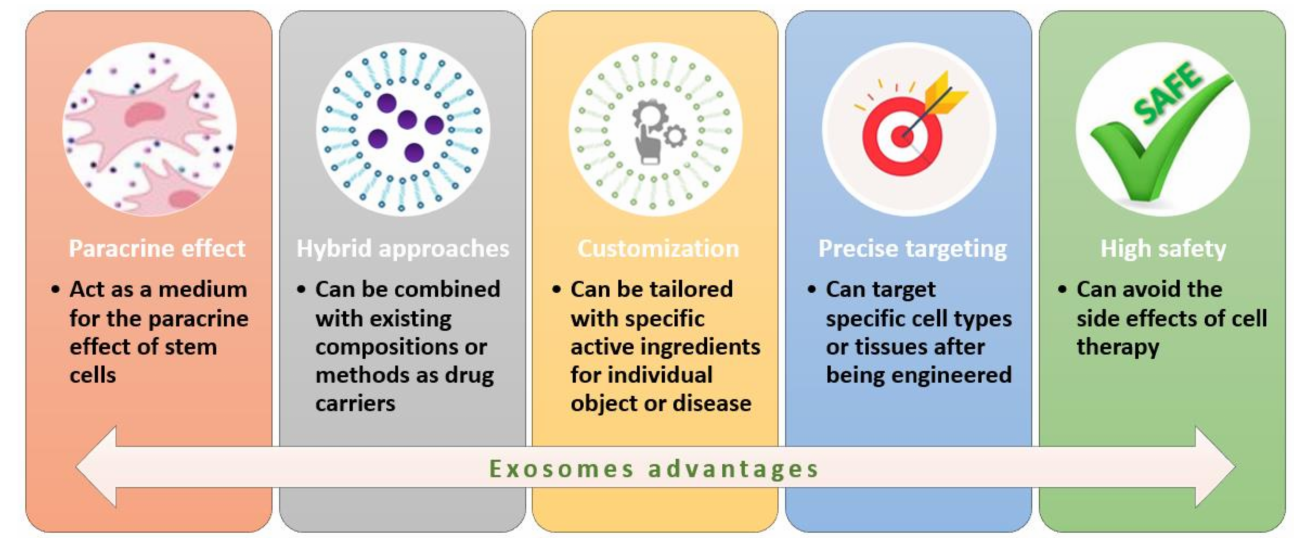
Figure 5. Advantages of using exosomes in regeneration therapies. Created based on information from